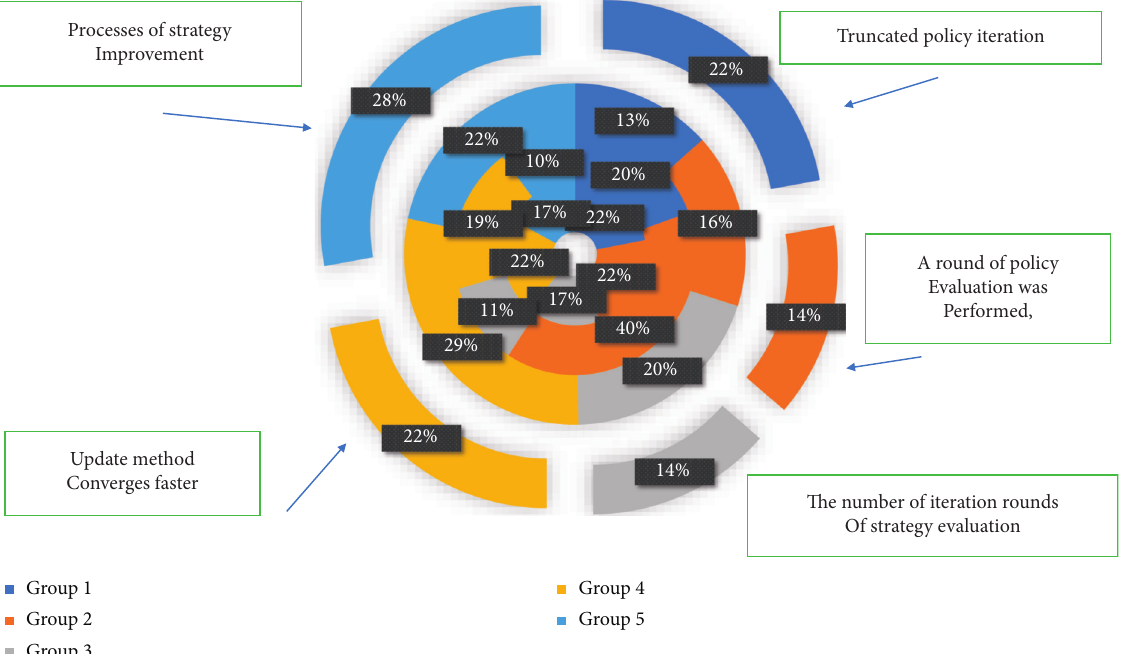
Figure 6: Machine learning strategy to improve the evaluation